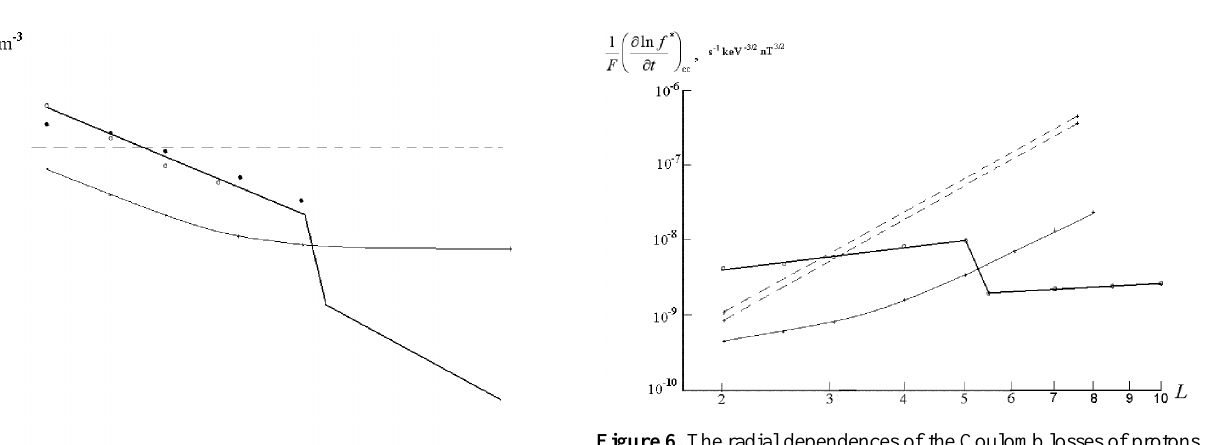
Figure 6. The radial dependences of the Coulomb losses of protons of the Earth’s radiation belts, normalized to f ∗ (L , µ) and F(L , µ) . The thick, thin and dotted curves correspond to the curves in Fig.